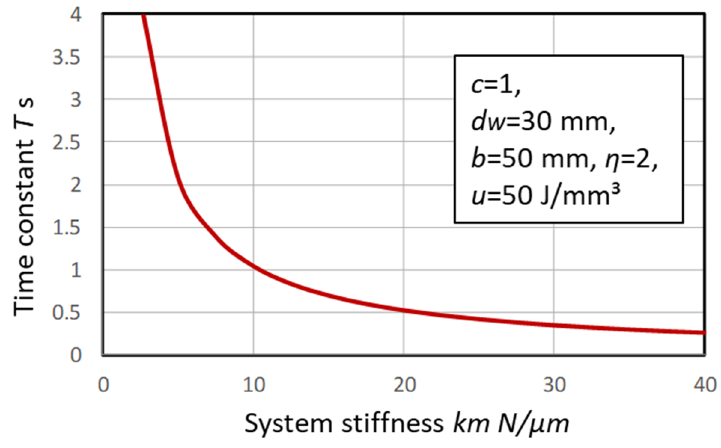
Figure 12. System stiffness and time constant.